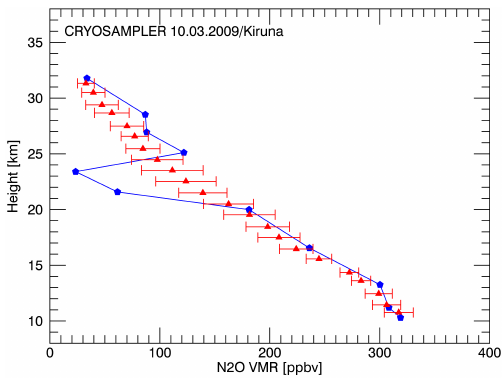
Figure 6. Same as Fig. 1, but instead of CH 4 now N 2 O.